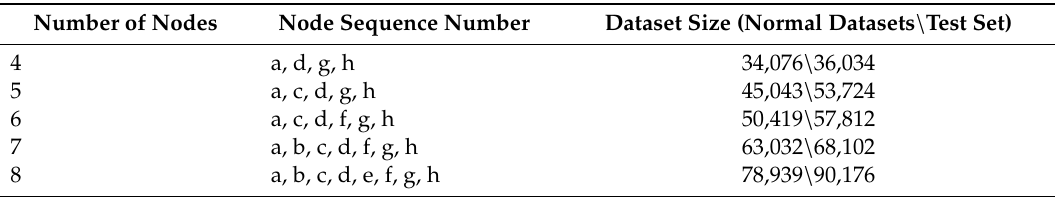
Figure 7. Impact of the number of antennas on the precision and recall.